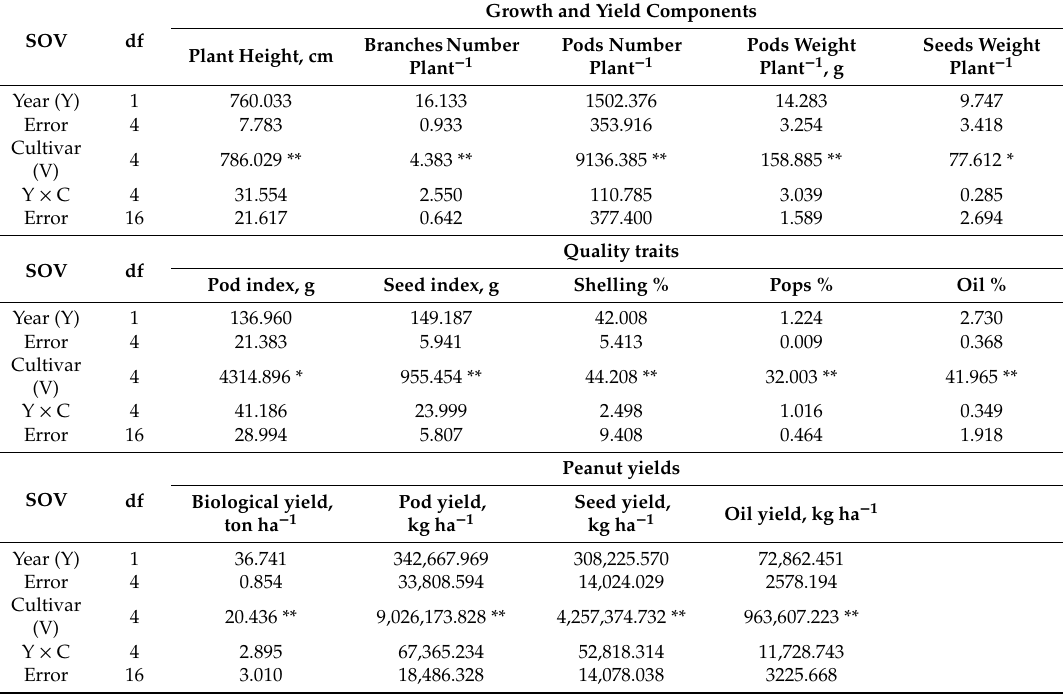
Table 3. Combined mean squares and treatments of the studied